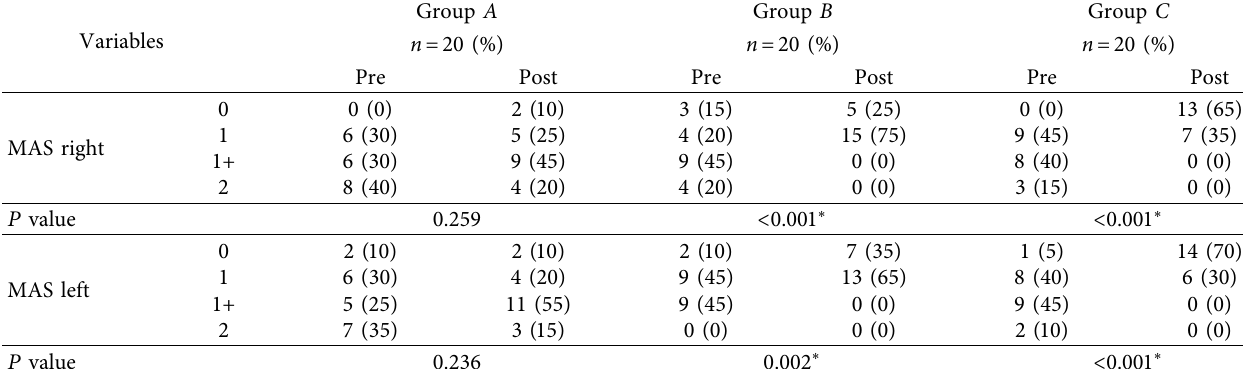
Table 3: Comparison of MAS pre- and post-therapy within each group in both Rt and Lt knees.